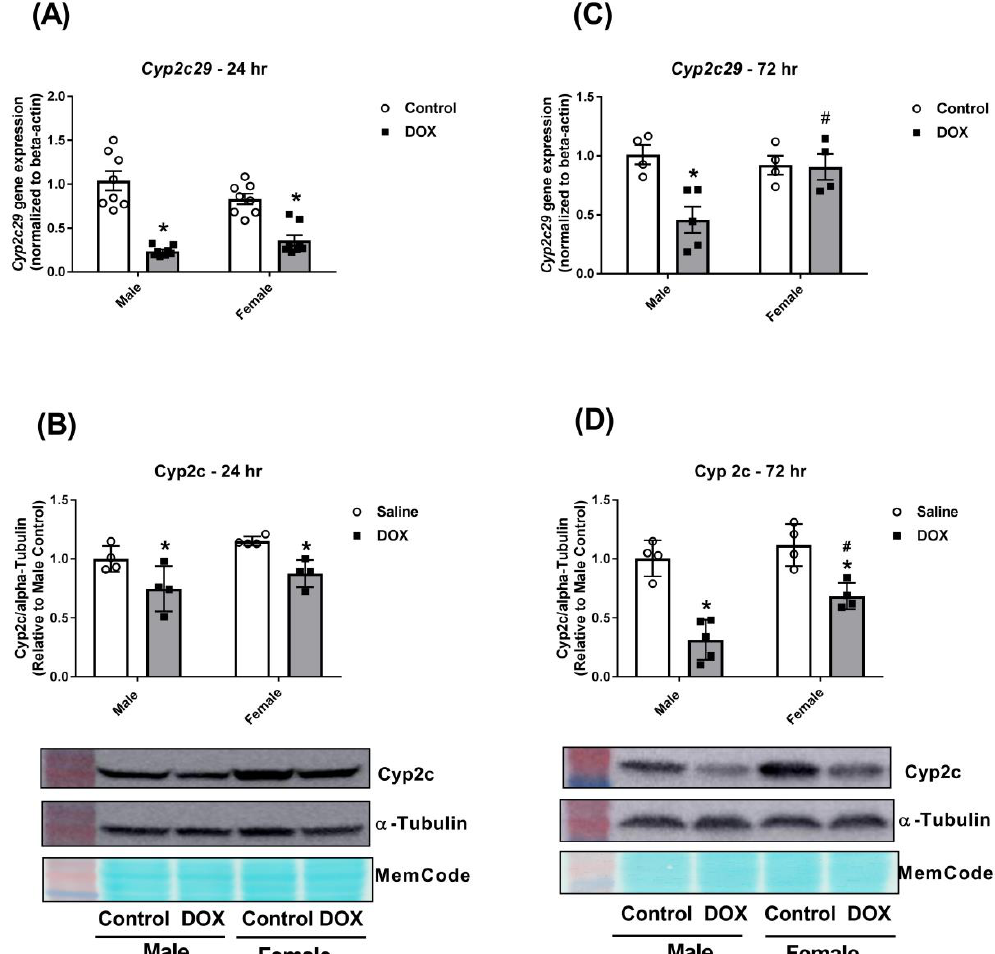
Figure 4. E ff ect of DOX treatment on the expression of the Cyp2c sub-family in the liver. Livers were collected from male or female C57Bl / 6 mice 24 or 72 h following the administration of a single intraperitoneal injection of 20 mg / kg DOX or saline, and total proteins and RNA were isolated. ( A ) Gene expression of Cyp2c29 was determined by real-time PCR ( n = 8 per group) and ( B ) protein levels of total Cyp2c were determined by western blotting ( n = 4 per group) in samples collected 24 h following DOX treatment. ( C ) Gene expression of Cyp2c29 ( n = 4–5 per group) and ( D ) protein levels of Cyp2c ( n = 4–5 per group) were determined in samples collected 72 h following DOX treatment. PCR results were normalized to beta-actin , and protein expression was normalized to alpha-tubulin. Results of all groups are expressed relative to the male control. Data are presented as the mean ± SEM. * p < 0.05, compared to control mice of the same sex; # p < 0.05, compared to male DOX-treated mice. DOX inhibited Cyp2e1 gene expression in both male and female mice 24 h after